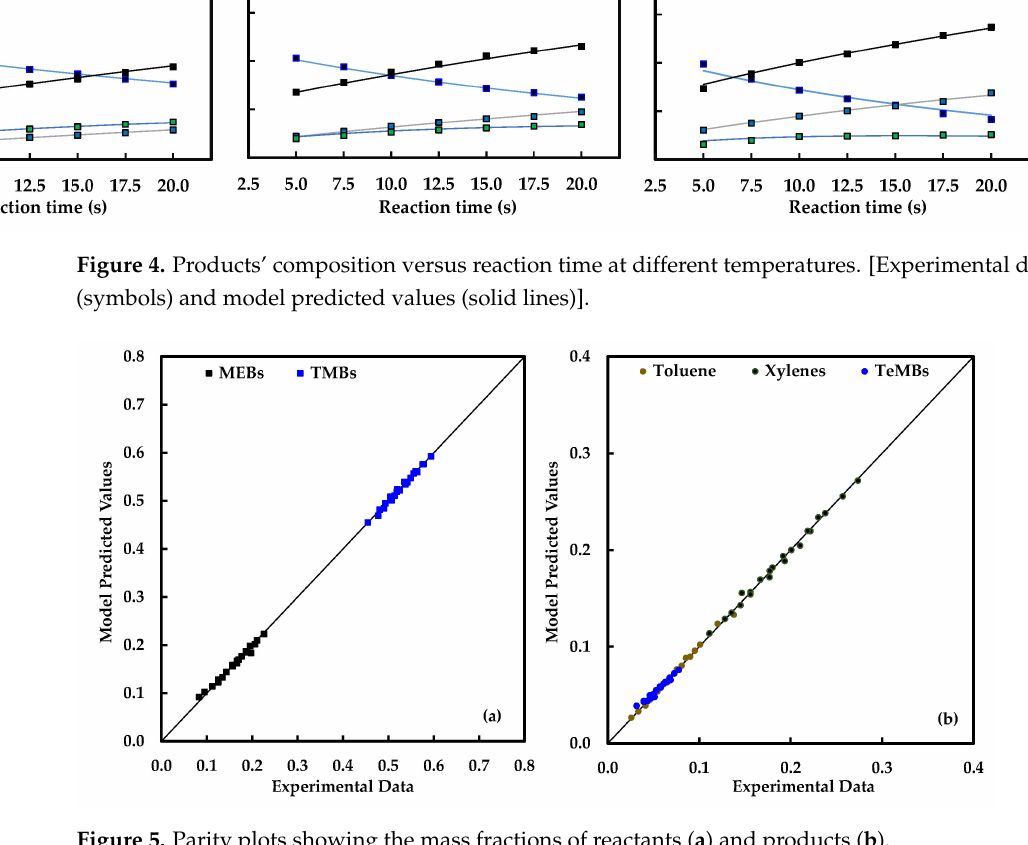
Figure 5. Parity plots showing the mass fractions of reactants ( a ) and products ( b